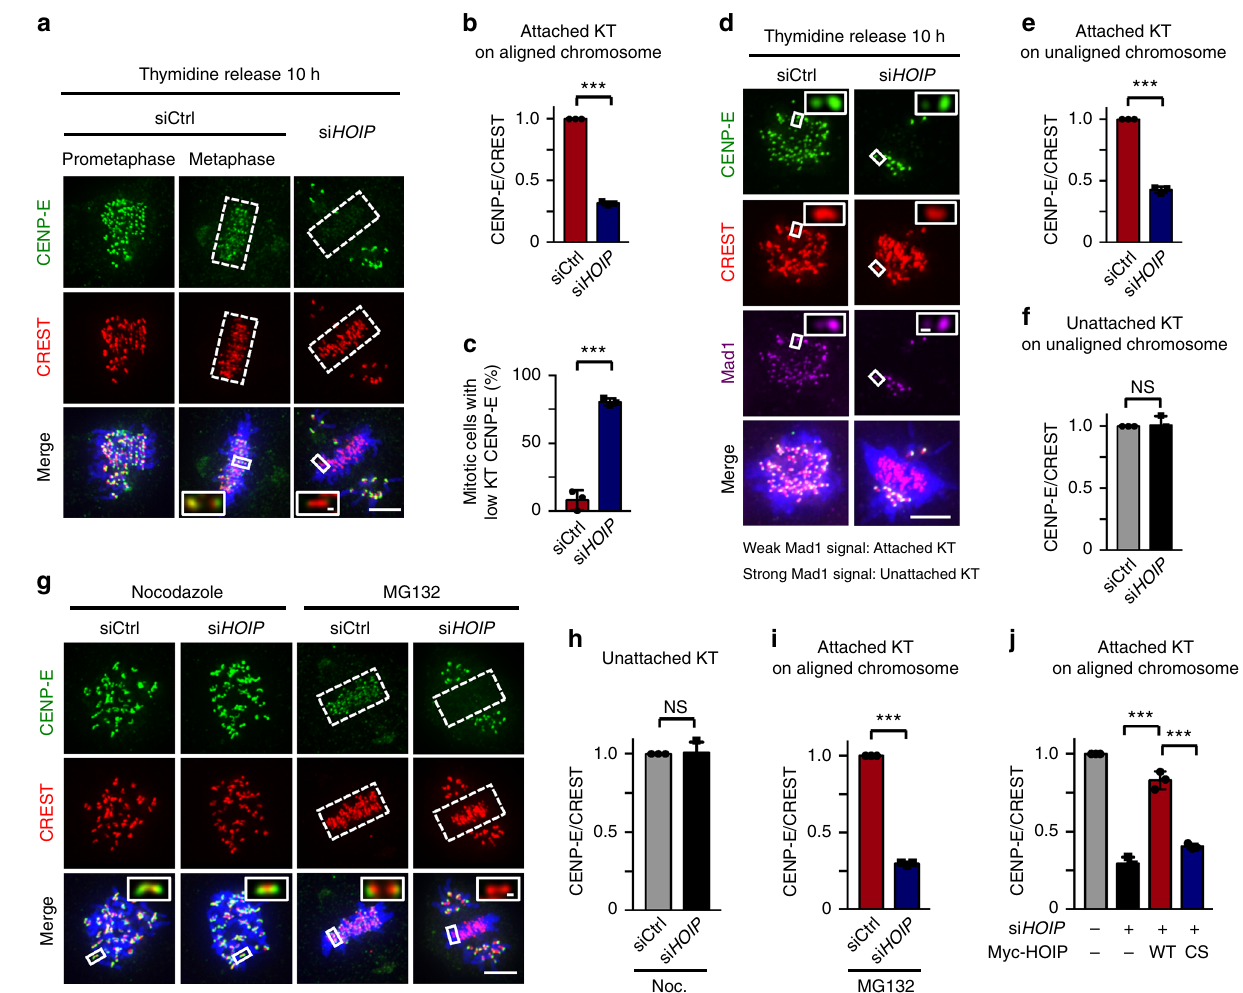
Fig. 2 LUBAC is critical for CENP-E localization on attached kinetochores. a CENP-E localization in control or HOIP depleted mitotic cells. Green, CENP-E; red, CREST; blue, DNA. b Quanti fi cation of relative intensity of kinetochore CENP-E on aligned (sicontrol, n = 23 cells; si HOIP , n = 20 cells) chromosomes in a . c Percentage of mitotic cells with less than 50% of relative intensity of kinetochore CENP-E on aligned chromosomes of control cells in control ( n = 23) or HOIP depleted ( n = 20) cells. d CENP-E localization at unattached (Mad1 signal, strong) kinetochores or attached (Mad1 signal, weak) kinetochores on unaligned chromosomes in control or HOIP depleted mitotic cells. Green, CENP-E; red, CREST; magenta, Mad1; blue, DNA. e , f Quanti fi cation of CENP-E signals at attached kinetochores ( e ) or unattached kinetochores ( f ) on unaligned chromosomes in d (sicontrol, n = 9 cells; si HOIP , n = 12 cells). g CENP-E localization in control or HOIP depleted mitotic cells synchronized by Nocodazole or MG132. Green, CENP-E; red, CREST; blue, DNA. h , i Quanti fi cation of relative intensity of CENP-E on unattached (Nocodazole treated) ( h , n = 19 cells in each group) or attached (MG132 treated) ( i , sicontrol, n = 17 cells; si HOIP , n = 18 cells) kinetochores in g . j Expression of GFP-HOIP WT, but not CS mutant, rescued CENP-E localization at attached kinetochores on aligned chromosomes. n = 15 cells in each group. Data are presented as mean ± s.d. of three independent experiments. The average CENP-E/CREST ratio of each group was normalized to control cells. Dashed boxes, regions of aligned chromosomes. Insets, zoomed-in views of the boxed regions. NS not signi fi